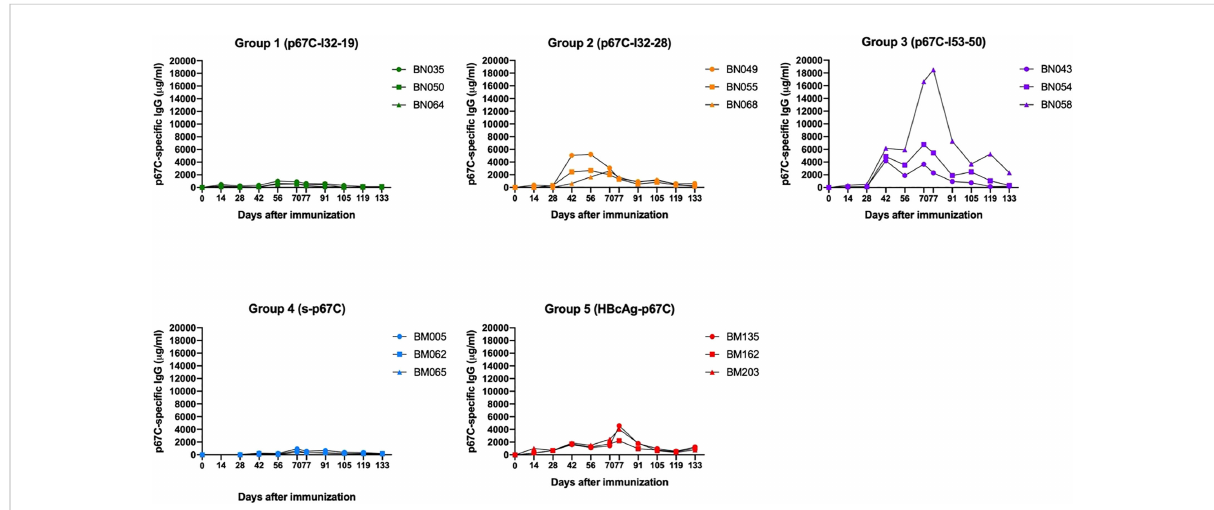
FIGURE 2 Kinetics of anti-p67C speci fi c total IgG levels from day 0 to day 133, approximately two and a half months after the third antigen dose. Antibody titers from cattle immunized with p67C-I32-19 (Group 1), p67C-I32-28 (Group 2), p67C-I53-50 (Group 3), s-p67C (Group 4) or HBcAg-p67C (Group 5); from previous experiments (35), are